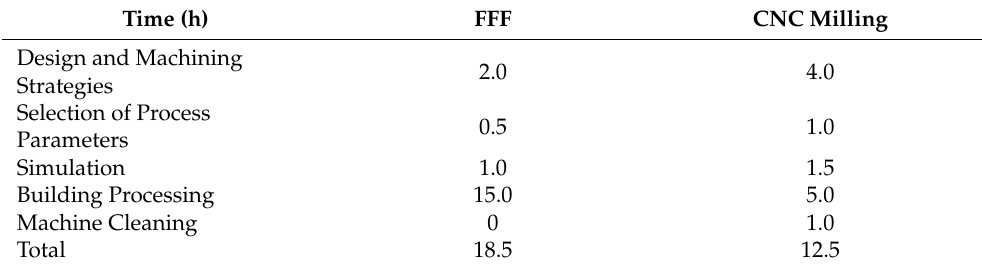
Table 2. Comparison between time (h) of CNC milling and FFF for the production of a column of the 17th-century tabernacle.